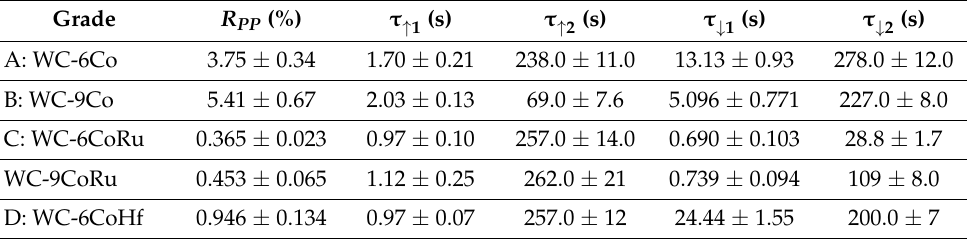
Figure 15. A selection of abrasion–repassivation transients measured in 0.5 M Na 2 SO 4 at 0.5 V vs. HM-QRE ( A ) and their fits ( B ), for the indicated set of samples listed in Table 1. For more details, refer to text. Table 7. Parameters extracted from quantitative analyses of the abrasion–repassivation transients of Figure 15.